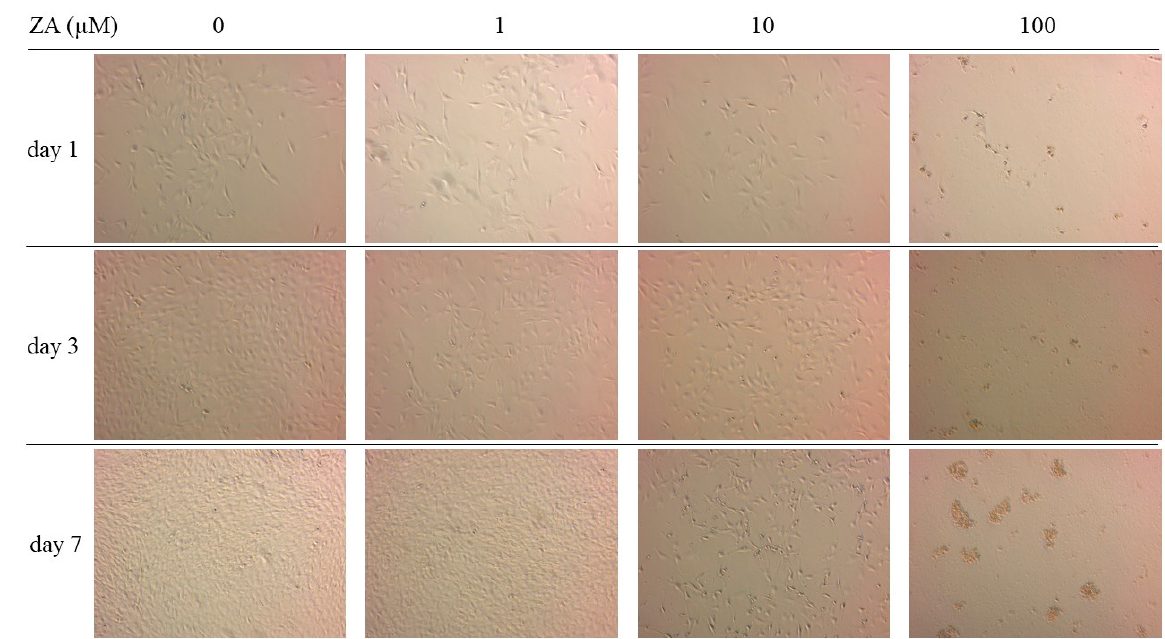
Figure 2. Influence of ZA on cell morphology of MC3T3-E1 cells. The highest concentration (100 µM) of ZA shows toxic effects against cells on days 1–7. In addition, 10 µM of ZA induces unusual morphologies on day 7.